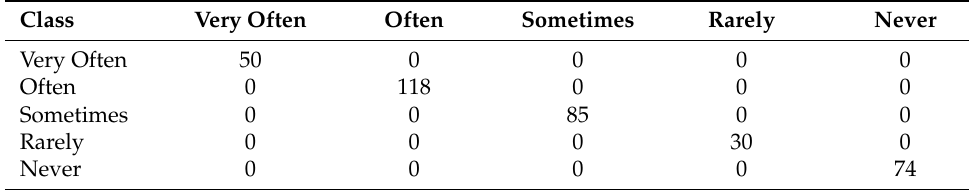
Table 4. Confusion matrix for random forest.